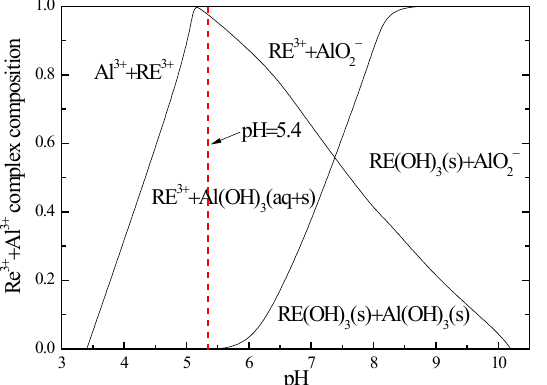
Figure 14. Composition of Al 3+ and RE 3+ in rare earth leaching solution varies with pH.